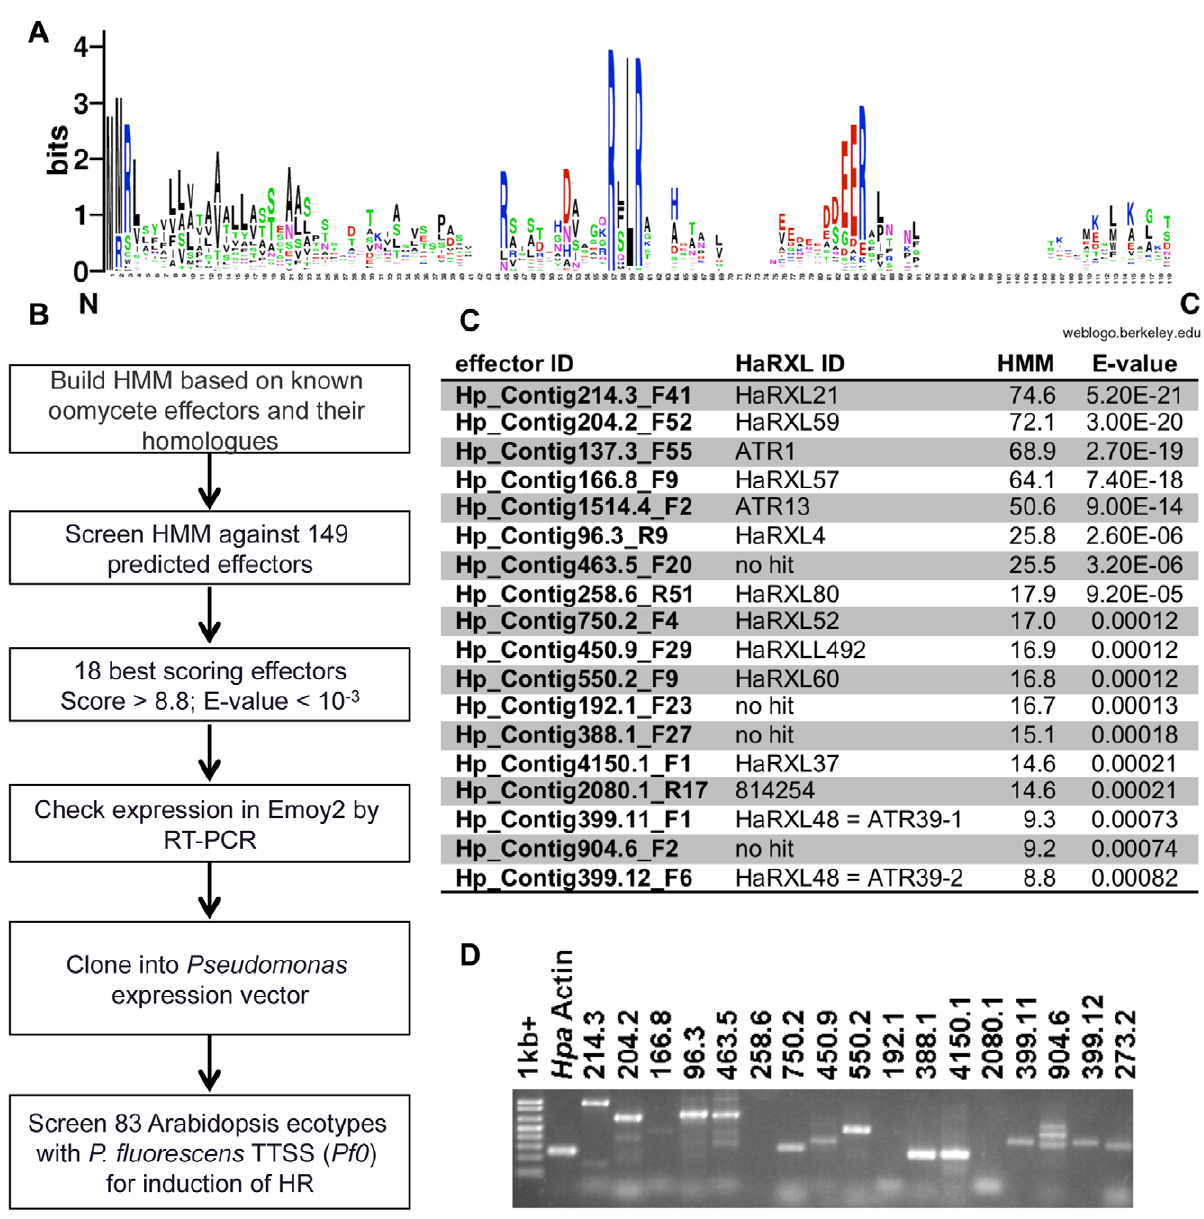
Figure 1. Identification of functional avirulence effector candidates from Hyaloperonosporaarabidopsidis(Hpa) using a Hidden Markov Model (HMM)–based search. A) Consensus sequence of 43 oomycete effectors used in building the HMM. The consensus was generated using the Weblogo program. Larger letters signify higher conservation. B) Screening scheme for identification of effectors. The steps in the pipeline are as follows: 1) Building HMM model based on N-terminal secretion signal and RXLR domains of known effectors; 2) Screening the HMM against 149 predicted effectors to form a prioritized list; 3) Focusing on 18 best scoring effectors with HMM score . 8.5 and E-value , 0.001; 4) Determining expression of predicted effectors in Hpa Emoy2 7 days post-infection (dpi); 5) Cloning expressed effectors in Pseudomonas vector pPsSP [35] or pEDV3 [36] and determining expression in P. fluorescens ; 6) Screening 83 Arabidopsis ecotypes with effectors for induction of resistance response, visible as HR. C) Summary of highest scoring effector candidates identified by HMM search. Effector IDs correspond to position on contigs in Hpa genome version 7.0. HaRXL IDs are the annotated IDs in the published Hpa genome version 8.3. ‘‘No hit’’ indicates genes not annotated in the final genome. HMM scores and E-values are indicated. D) Expression of effectors in Hpa Emoy2 infected tissue 7 dpi as determined by